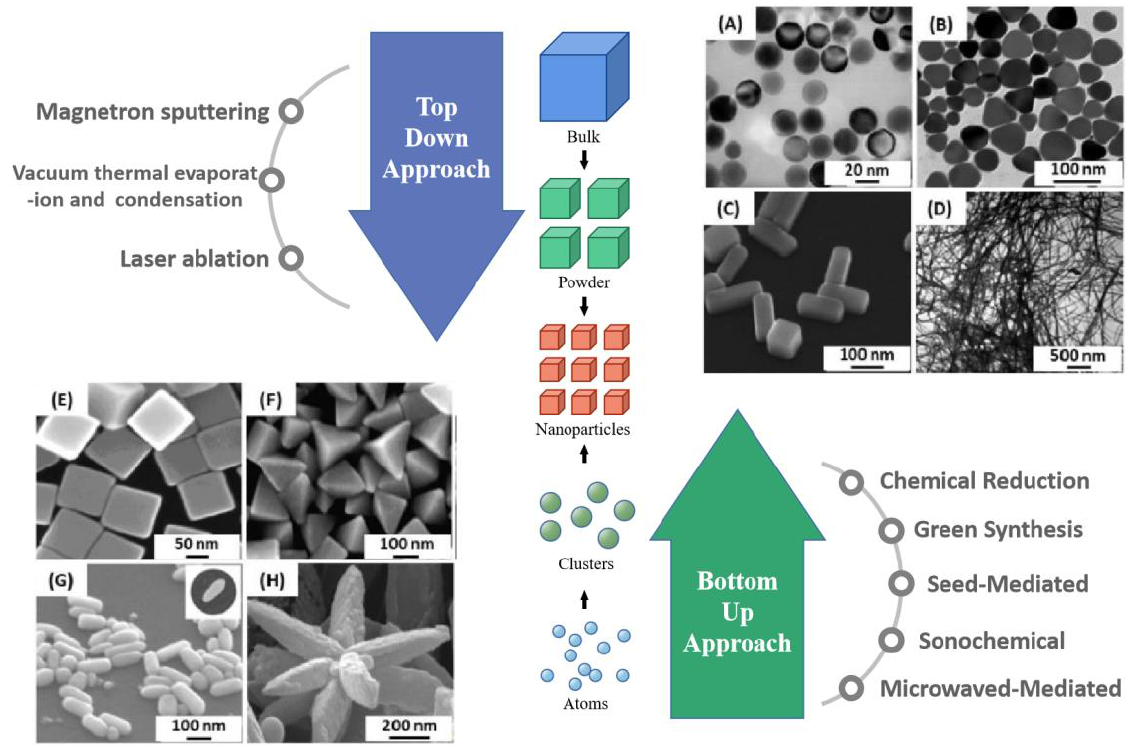
Figure 2. Top-down and bottom-up approach for fabricating Ag NPs. Major synthetic approaches for the fabrication of Ag NPs. TEM images of silver nanoparticles with different shapes: ( A ) nanospheres Reprinted with permission from Ref. [41]. Copyright 2004, Nano Letters. ( B ) nanoprisms